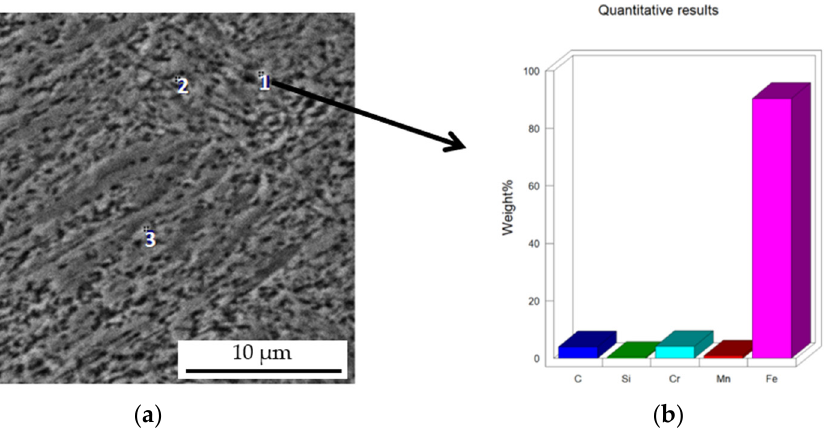
Figure 13. Microstructure of the flux-cored arc-hardfaced coating on the turbocharger shaft journal with micro-areas (points1–4) ( a ), bar chart of elemental content in micro-area 1 ( b ). Table 1. The result of the micro analysis of the chemical composition from points 1–4. The compact- ness of the elements % by weight.